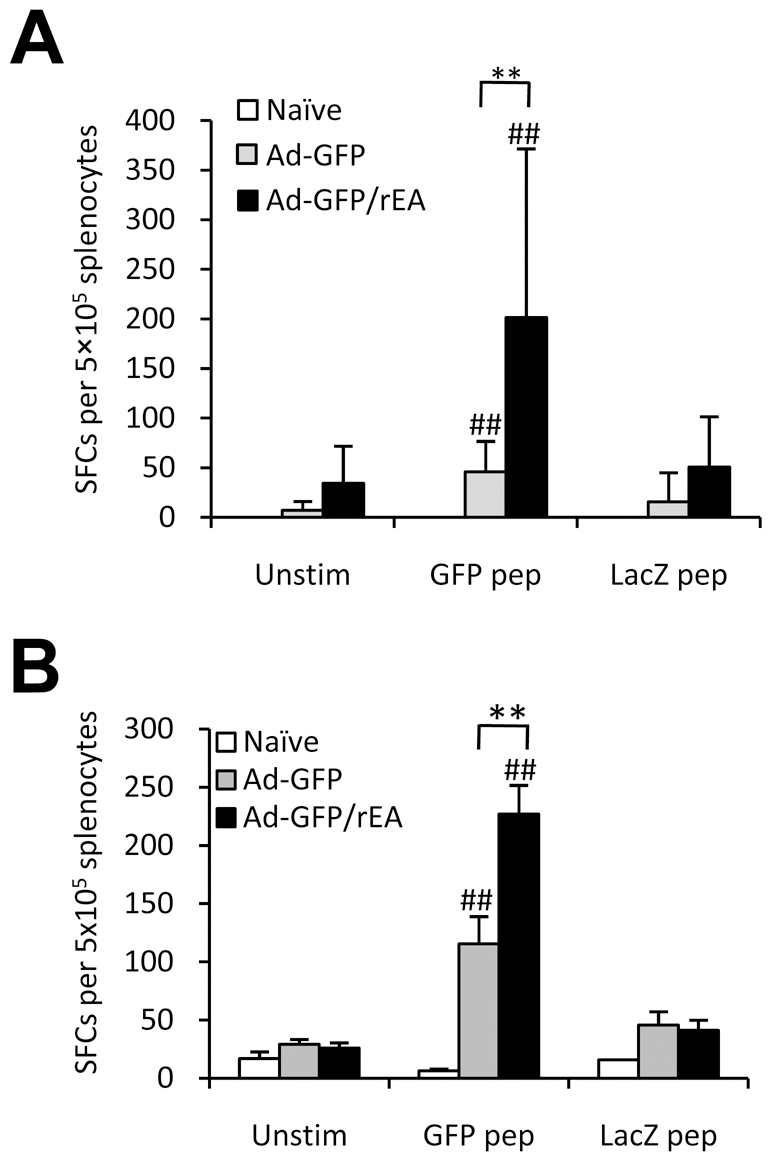
Heightened transgene specific cellular responses as a result of Ad-GFP/rEA injection.(A) C57BL/6 mice were mock injected (n = 3) or IV injected with 1×1010 vp of either Ad-GFP or Ad-GFP/rEA (n = 8). Splenocytes were harvested 7 dpi and used to complete IFNγ ELISpot analyses. Spot forming cells (SFCs) are reported. (B) C57BL/6 mice (n = 6) were injected IM as above. IFNγ ELISpot analyses were completed at 14 dpi. Bars represent mean ± SE. ## represent significantly different from mock injected mice (p<0.01). *,** represent statistical differences (p<0.01).